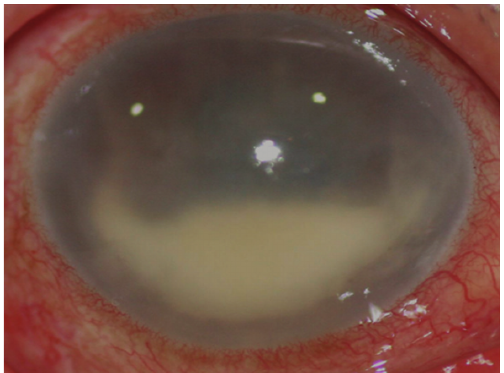
Figure3:BiomicroscopyODafter2weeks—cataractandnocorneal edema or hypopyon.